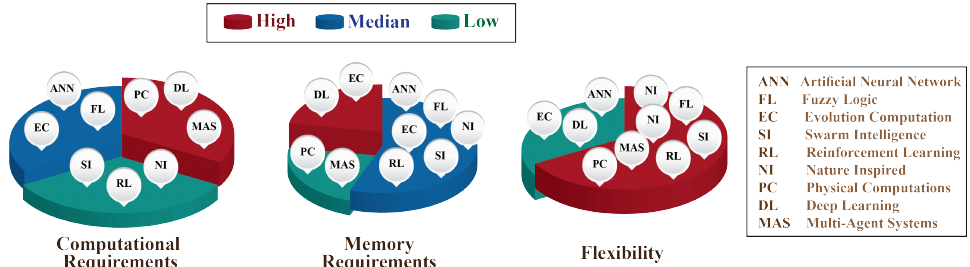
Figure 6. General comparison of computational, memory, and flexibility requirements of utilized AI